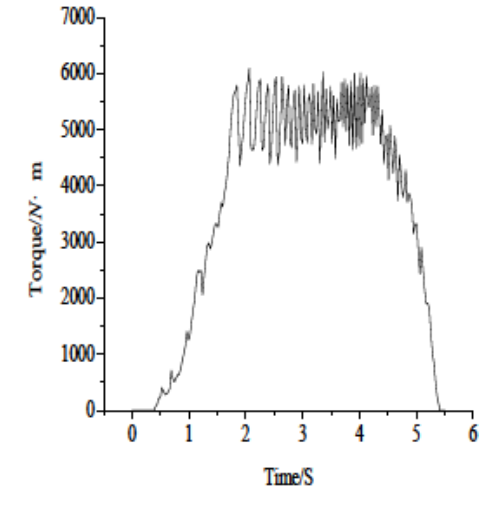
Figure 4: Torque